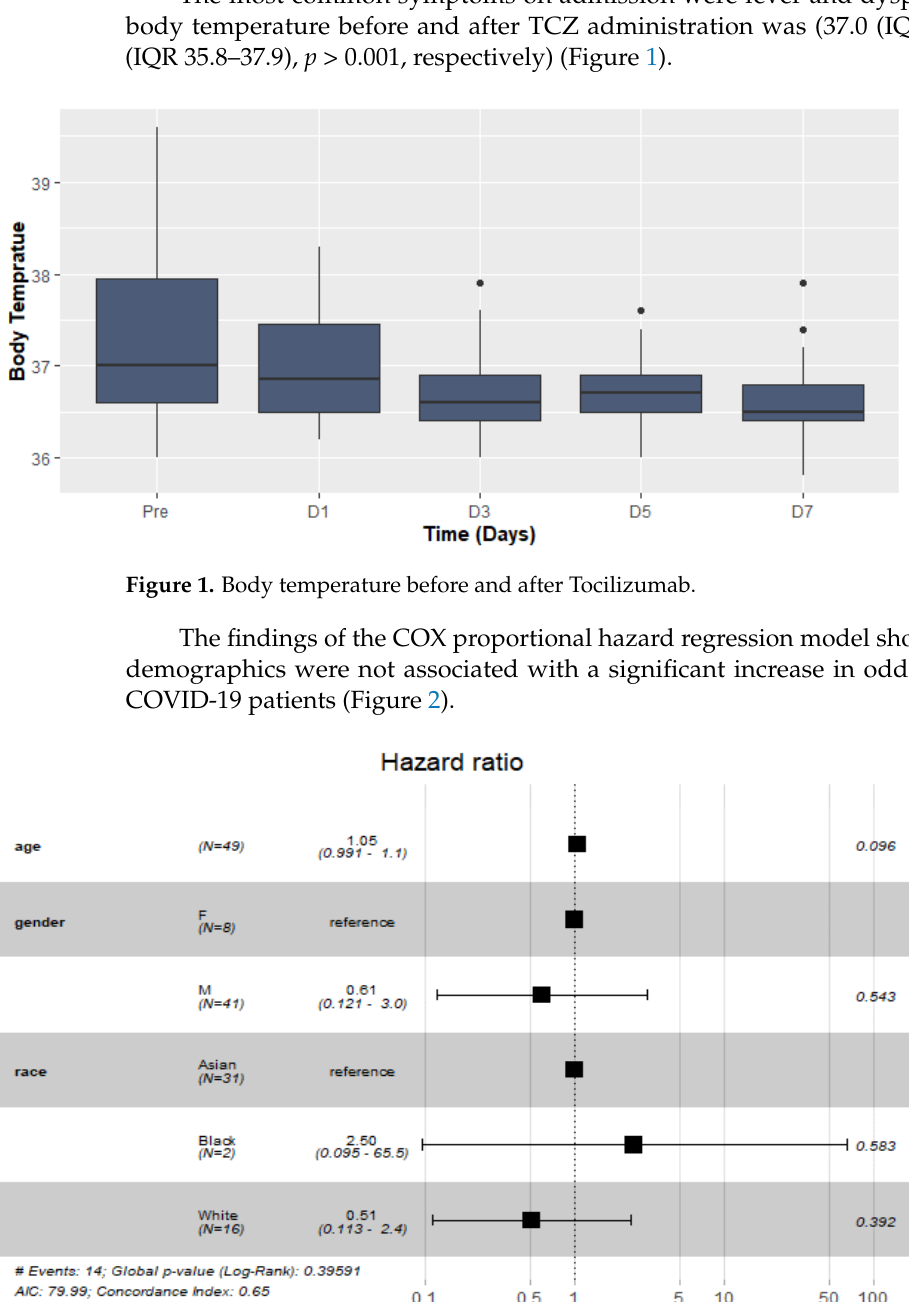
Figure 2. Cox proportional hazard model with demographic characteristics.